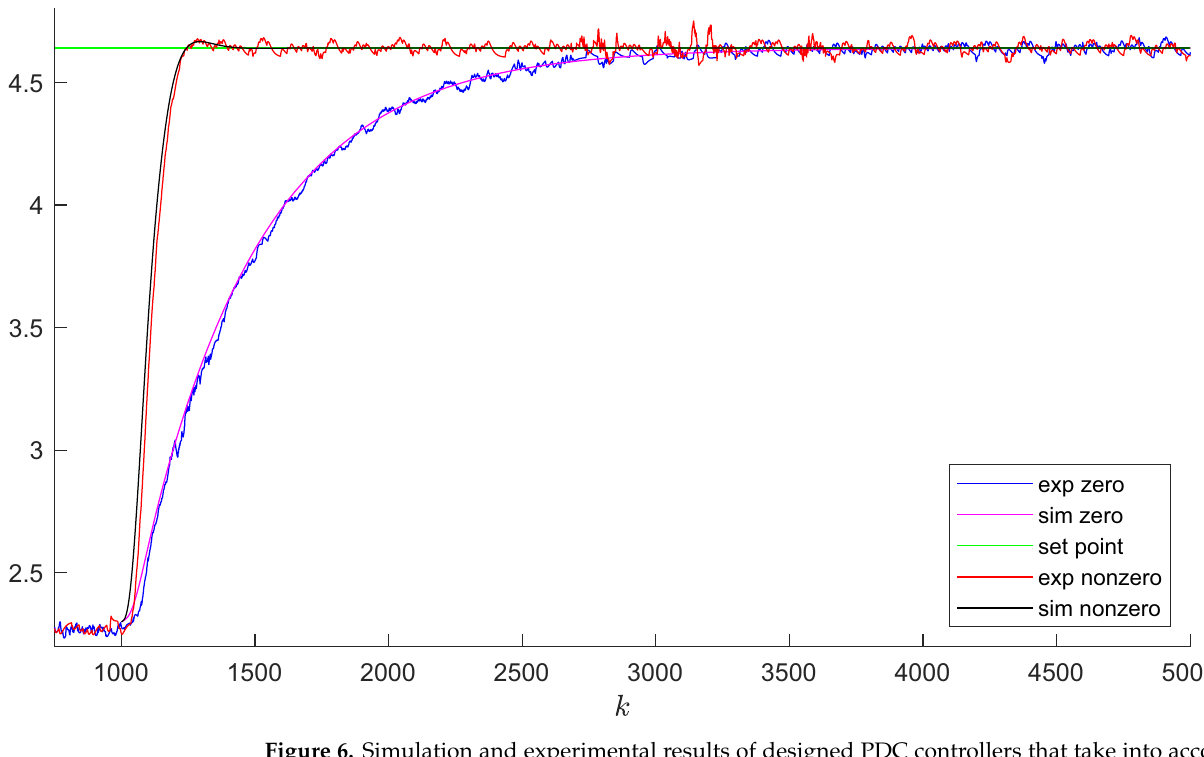
Figure 6. Simulation and experimental results of designed PDC controllers that take into account zero and nonzero initial